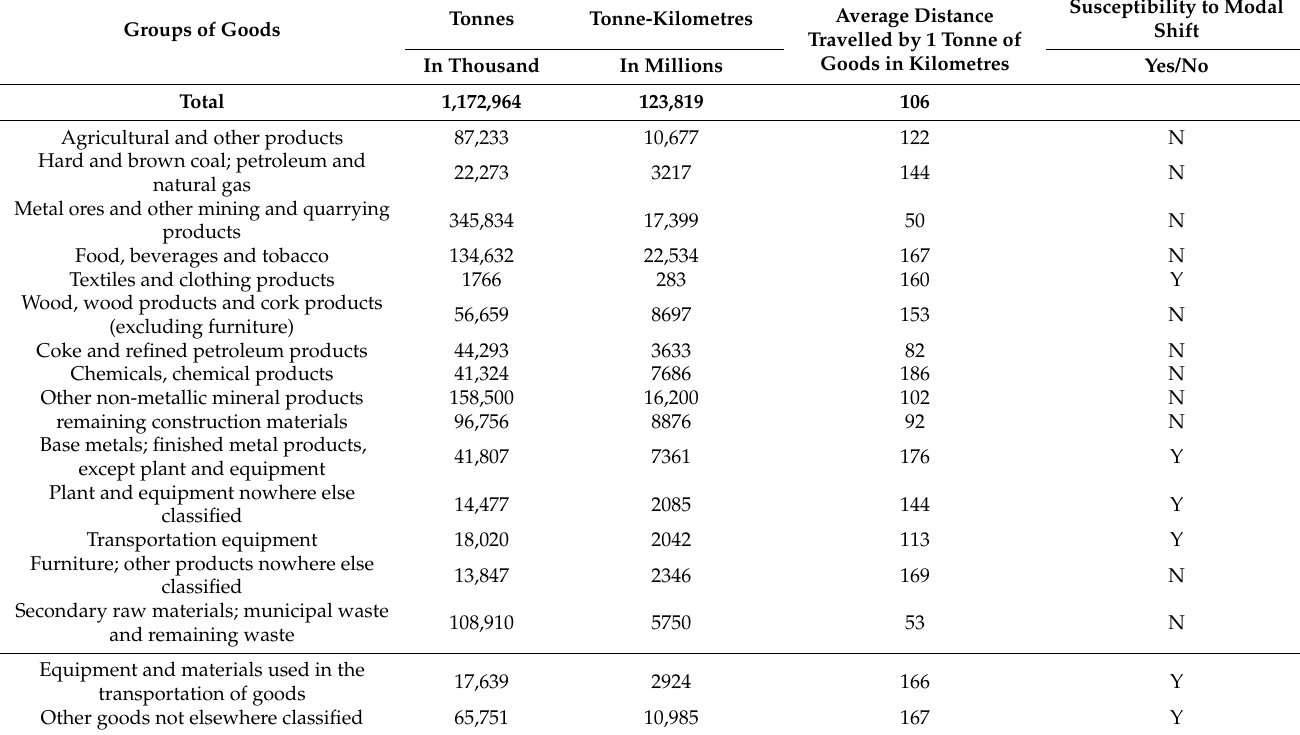
Table 1. The structure of road haulage in Poland in 2020.